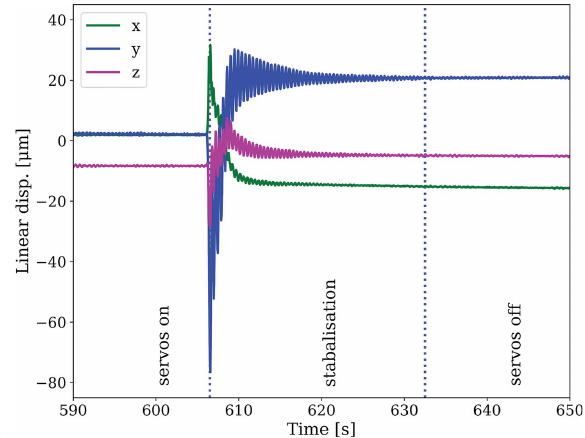
Figure 10 Vibrations measured using the capacitive sensors. The vibration levels with servo motors switched on and switched off are at a similar noise level. The stabilization period after switching the servo motors off is of the order of 30